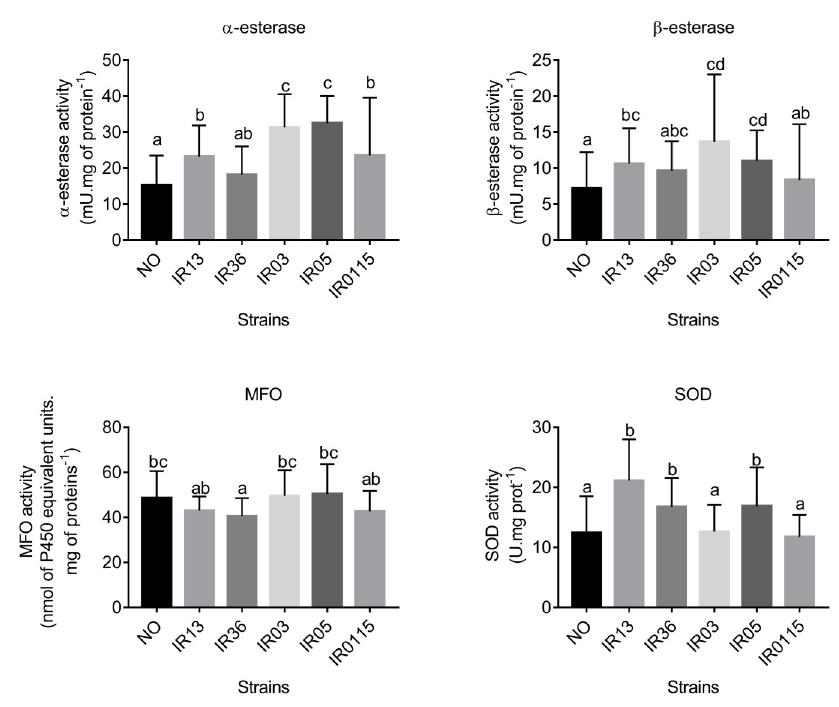
Fig 3. Activities of alpha-esterase, beta-esterase, mixed-function oxidases (MFO) and superoxide dismutase (SOD) in laboratory strains of Aedes aegypti IR13, IR36, IR03, IR05 and IR0115 and in the reference strain New Orleans (NO). Letters indicate significant differences. Values are the means ± SD of 50 individual mosquitoes for each strain.